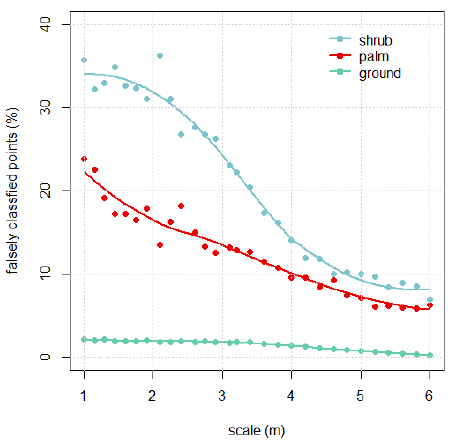
Figure 2: Proportion of falsely classified palm and shrub points (%) for different scale ranges. For each of the classifications a step-wise exclusion of the largest scales was performed. For vi- sual interpretation a loess fit was calculated for both the palm and shrub classification results. The shown graph is based on the 100m